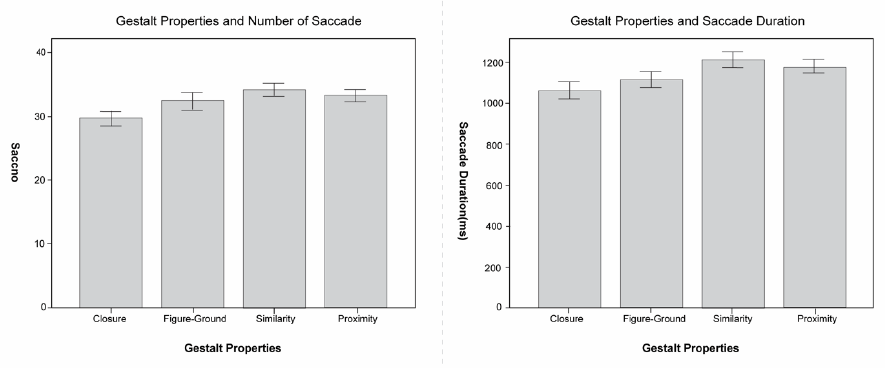
Figure 7. The Number of saccades and saccade duration of different gestalt properties